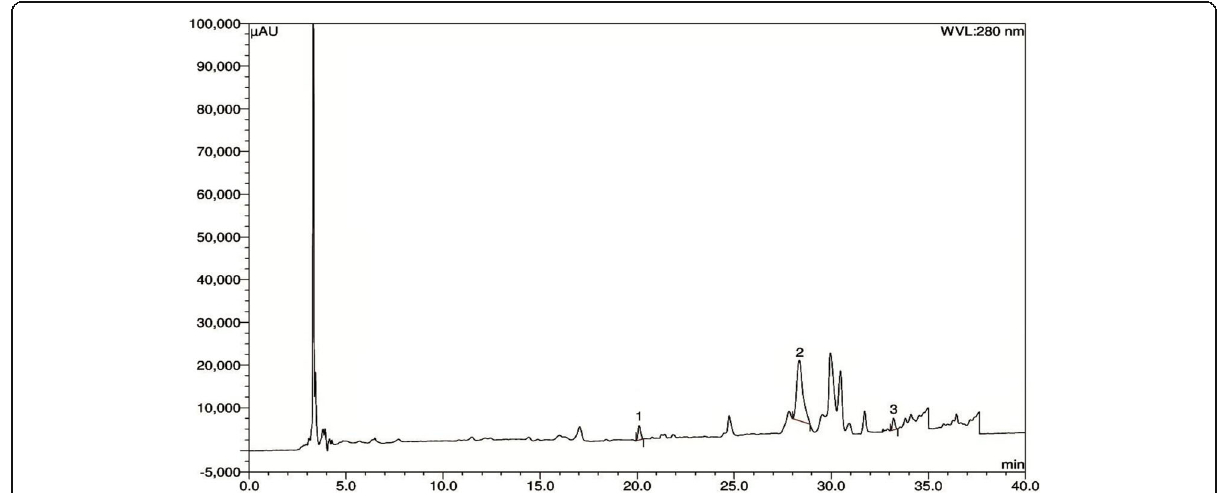
Fig. 3 HPLC chromatogram of ethanolic extract of S. caseolaris fruits. Peaks: 1, Vanillic acid (0.0274 %); 2, Ellagic acid (0.0031 %); 3, myricetin (0.0079 %)